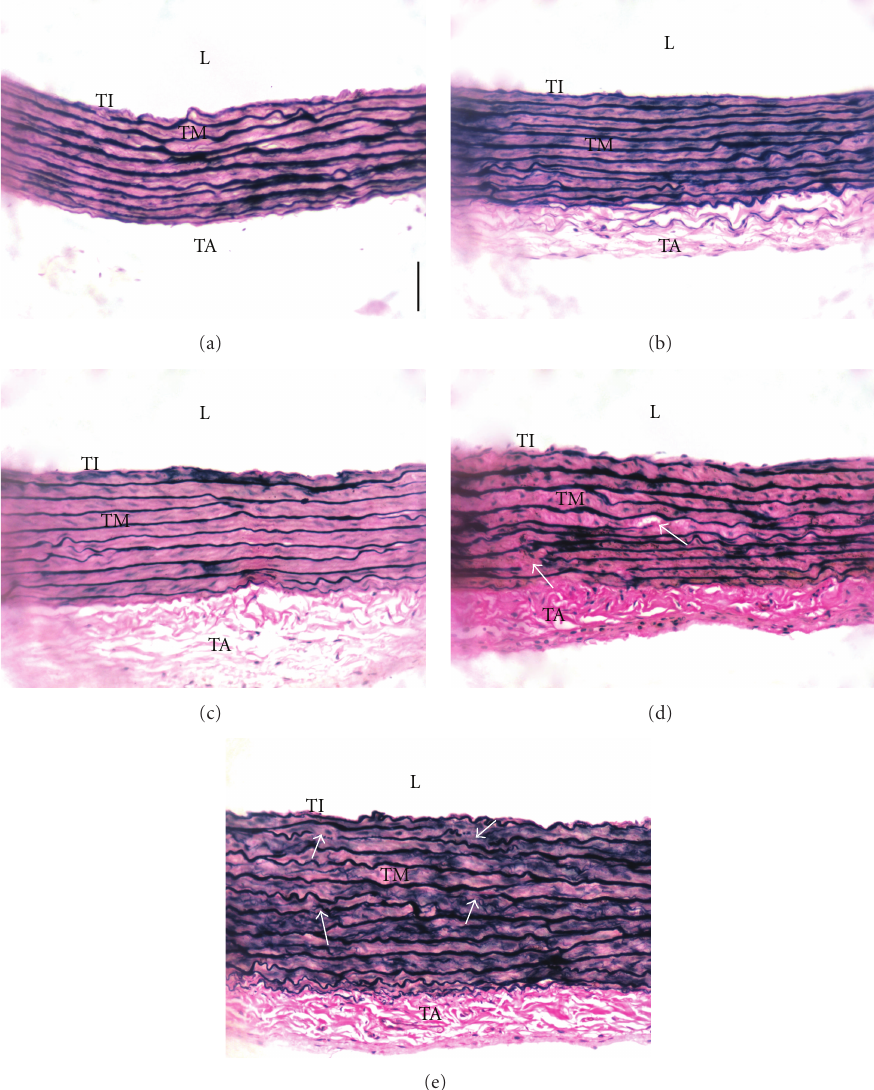
Figure 2: Photomicrographs of aortic sections stained with Verhoe ff -Van Gieson. Groups are as follows: (a) control rats; rats fed, (b) fresh (FPO), (c) one-time-heated (1HPO), (d) five-time-heated (5HPO), or (e) ten-time-heated palm oil (10HPO). Thickened tunica media is observed in 5HPO and 10HPO groups [(d) and (e)], with an increased interlamellar space when compared to the control and FPO groups [(a) and (b)]. Disorganisation and fragmentation of the elastic lamellae were also observed in 5HPO and 10HPO (arrow, (d) and (e)). L: lumen; TI: tunica intima; TM: tunica media; TA: tunica adventitia. Same magnification is applied to all pictures ( × 200). Calibration bar = 50 μ